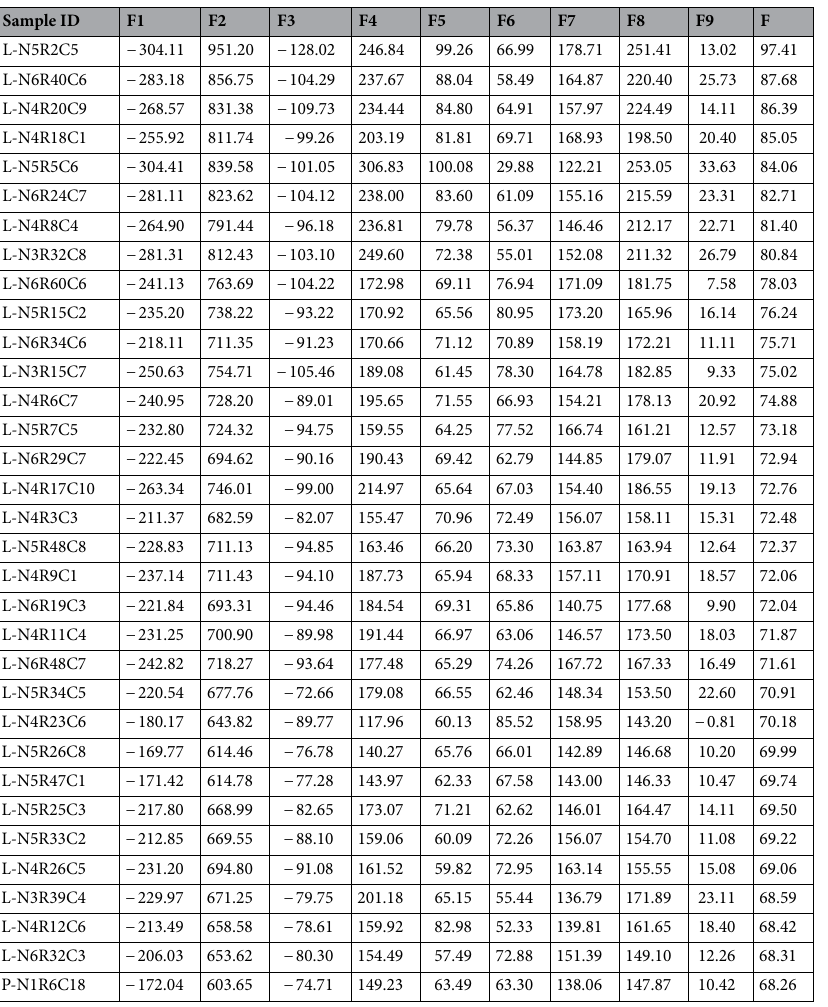
Table 5. Principal component values of 33